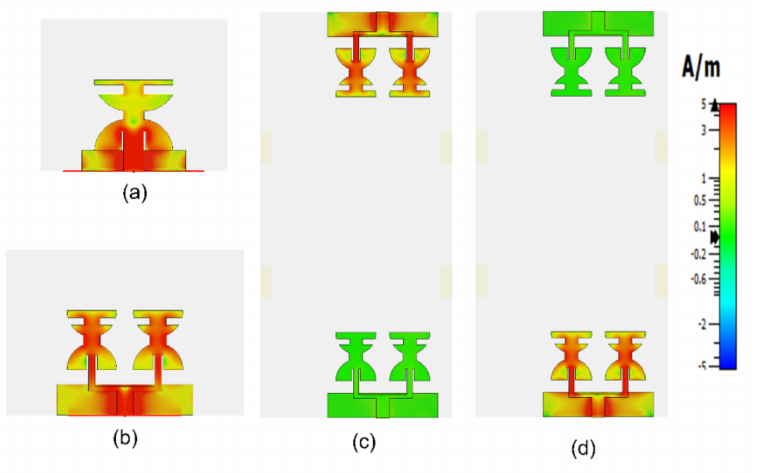
Figure 9. Surface current for the mid-band MIMO final and progression stages: ( a ) single-element surface current distribution; ( b ) array surface current distribution; ( c ) MIMO-1 surface current distribution; ( d ) MIMO-2 surface current distribution.